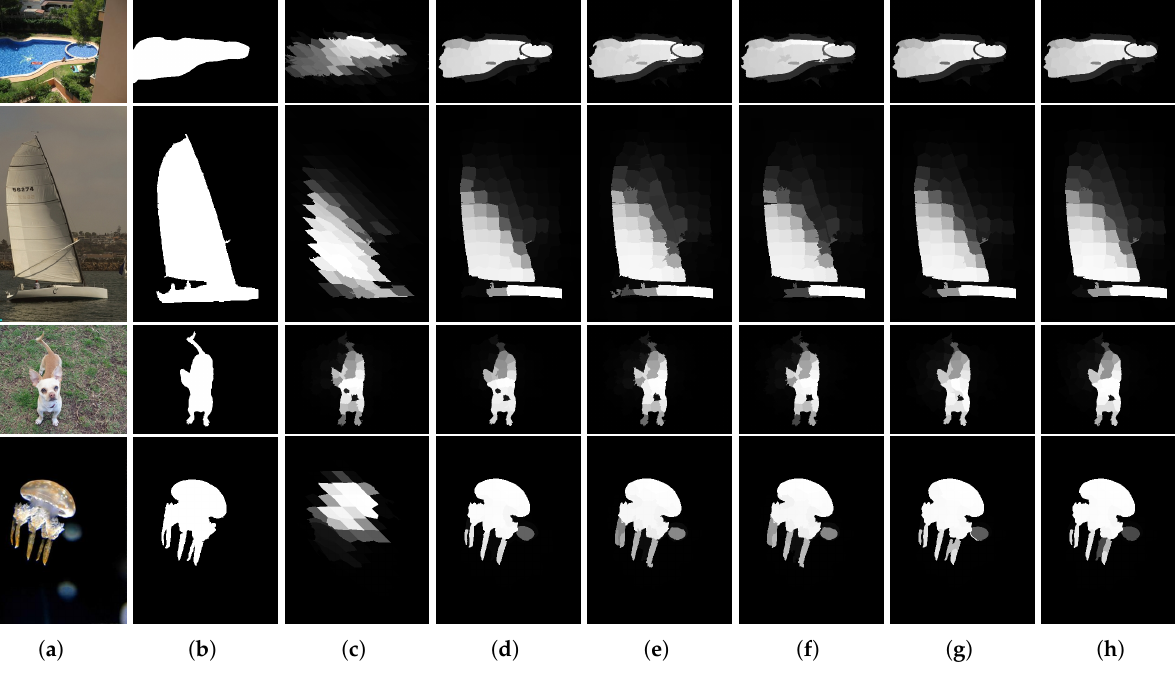
Figure 5. Visual comparison for GMR [16]. ( a ) Input images; ( b ) ground truth; ( c ) results of GMR; ( d ) BF; ( e ) ODOG; ( f ) LODOG; ( g ) BF+ODOG; ( h )